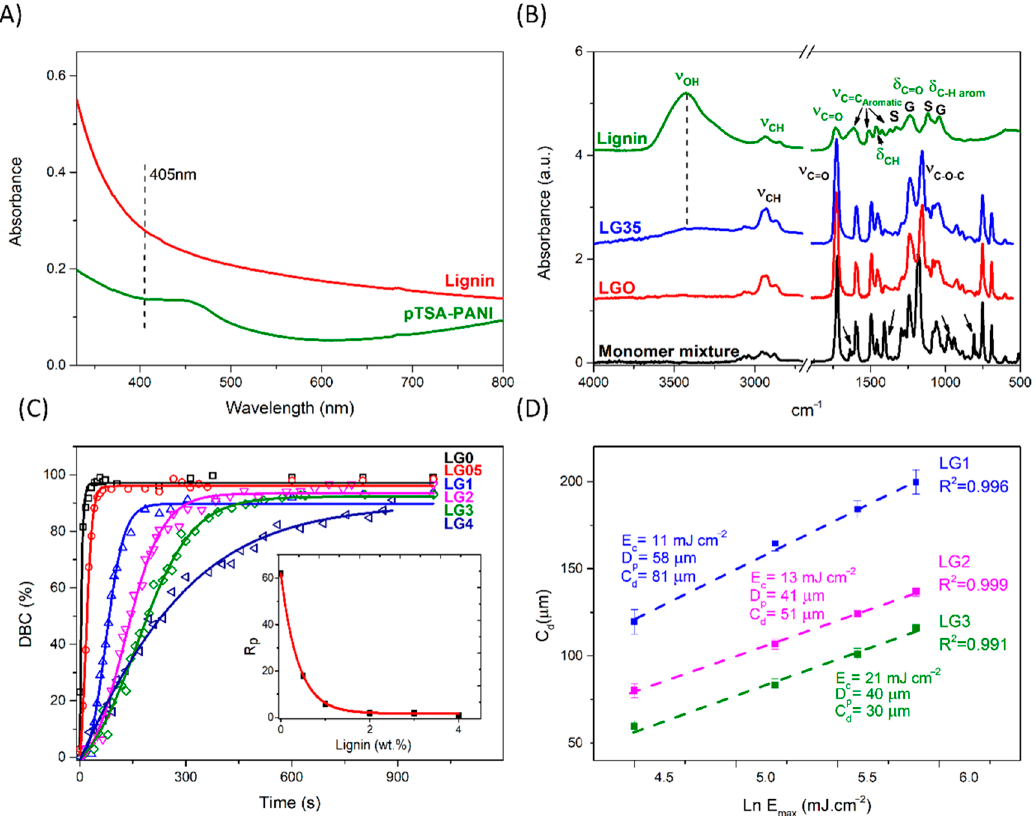
Figure 2. ( A ) UV-visible absorption spectra of lignin and pTSA-PANI in glycerin at 150 ppm. ( B ) ATR-FTIR spectra of the monomer mixture, pristine acrylic (LG0), LG35, and Lignin. ( C ) ATR conversion curves versus irradiation time for acrylic dispersions with 0.5, 1, 2, 3, and 4 wt.% lignin. The experimental data (symbols) were fitted with Boltzmann sigmoidal equation (lines) and ( D ) Jacobs working curves showing cure thickness as a function of the natural log of UV dosage for LG1, LG2, and LG3 formulations. Linear regressions are depicted.